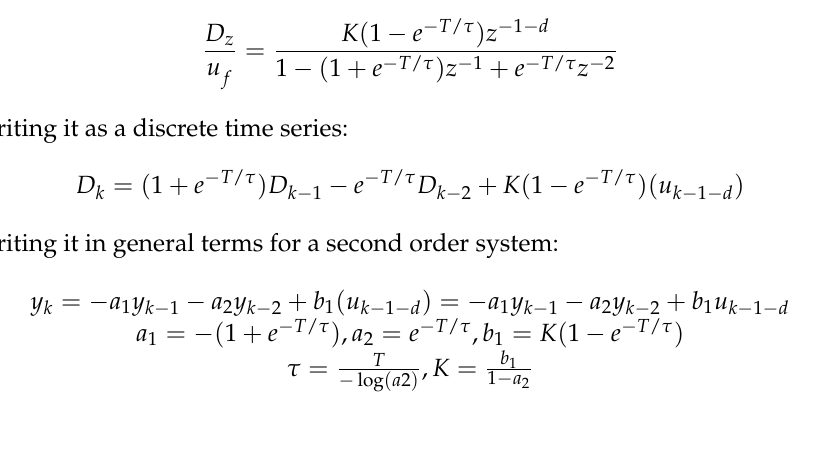
Figure 13. Fixing chart of the vertical propellers. U = 55.062 corresponds to a propeller thrust of 0.32 kg. The combined thrust of the two propellers is 0.27 kg. The “Arctic AUV” has a positive buoyancy of 2.7 N. Applying the Z transformation to